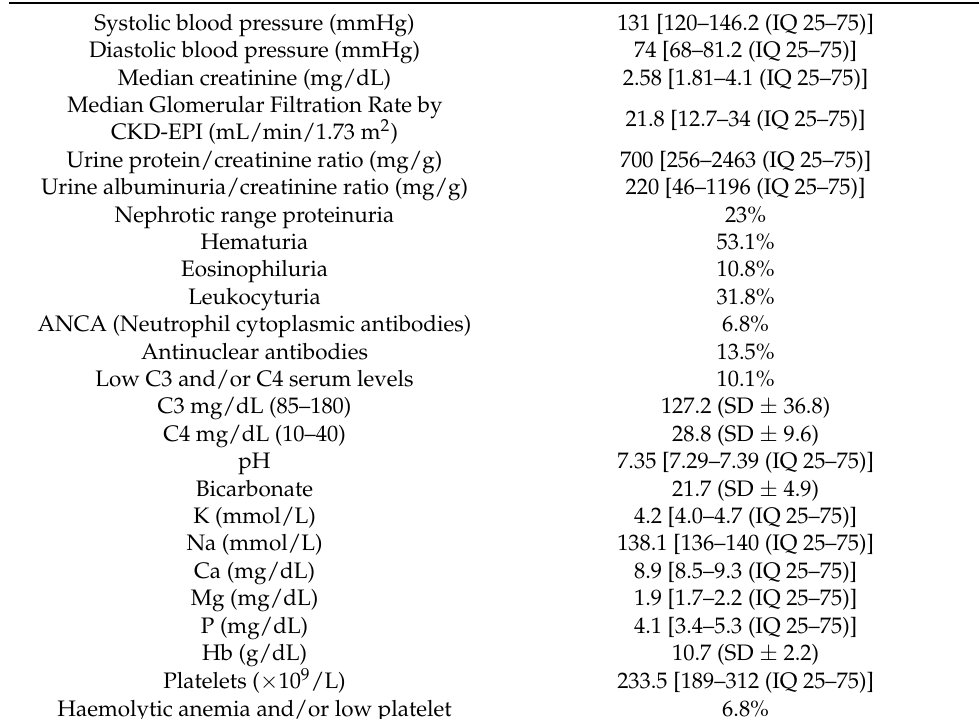
Table 2. Clinical and laboratory characteristics at the time of renal biopsy.